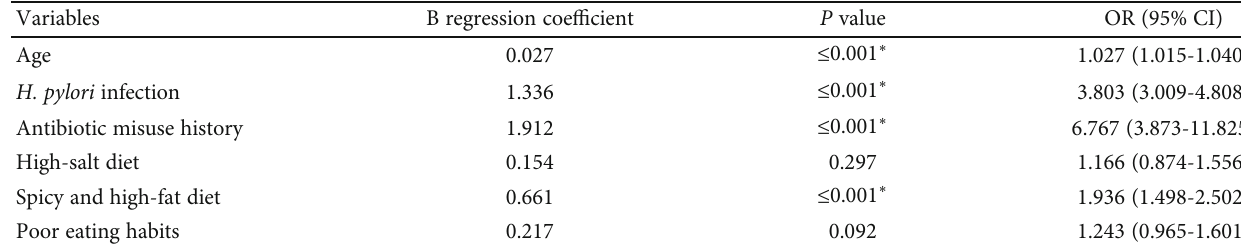
Table 3: Multivariate analysis of relevant risk factors for